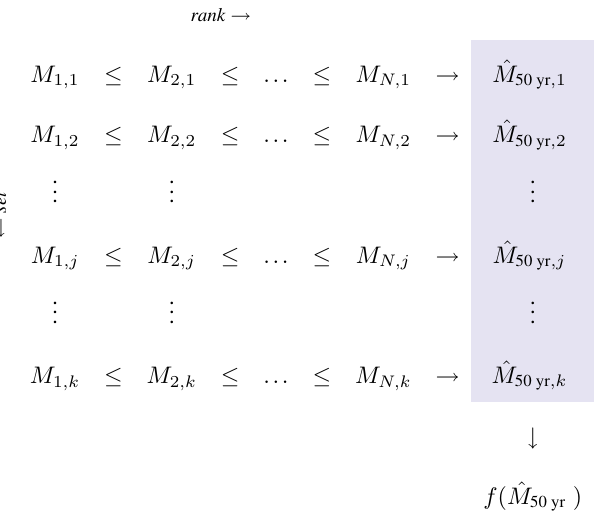
to the lowest 90% and highest 10% loads, respectively.